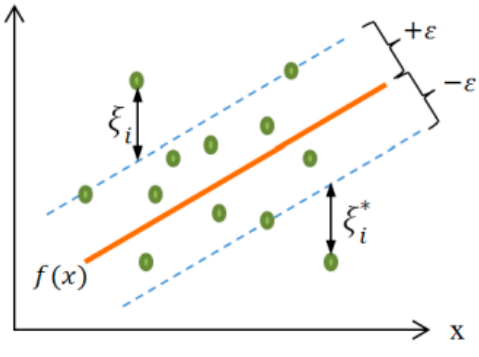
Figure 10. Linear support vector regression.